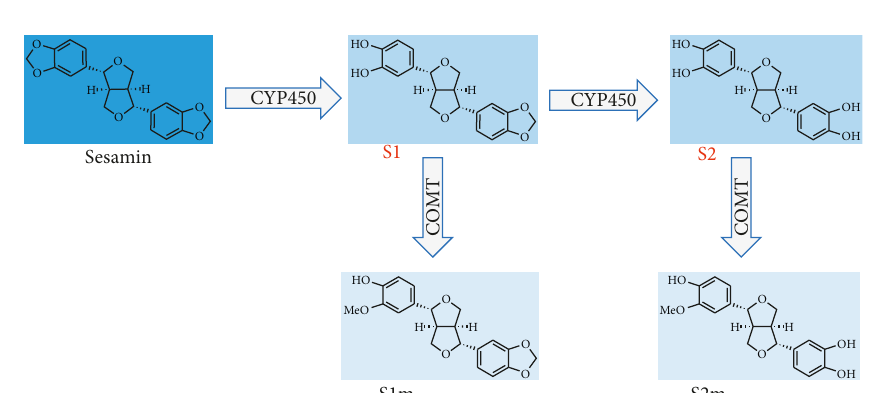
Figure 3: Scheme of sesamin metabolism in the liver.